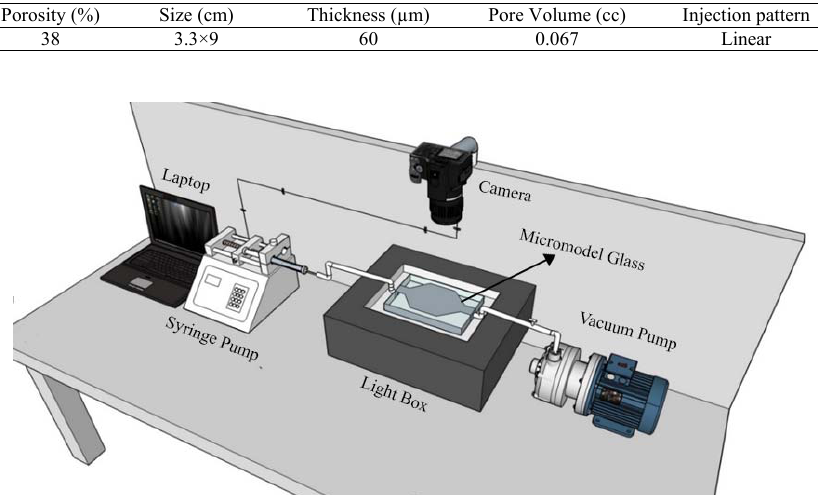
Table 2. Physical Properties of the micromodel